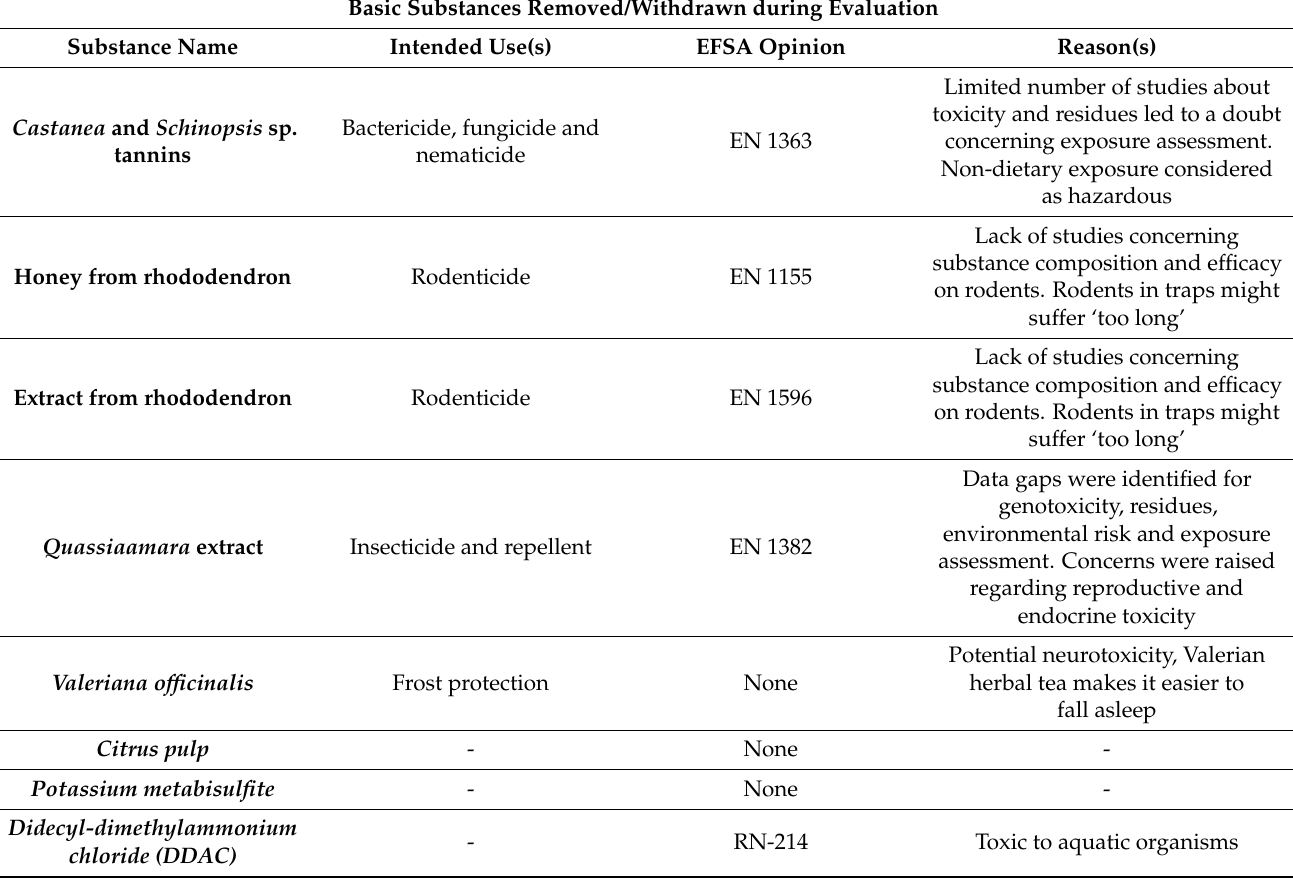
Table 3. Basic substance applications retired during the evaluation process.